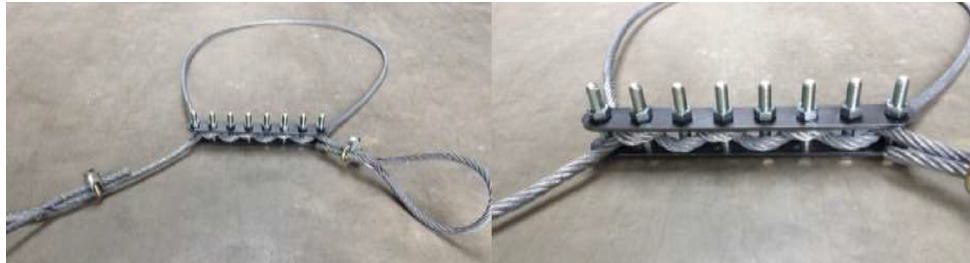
Figure 3. Image of the snake brake provided by the NGE Foundation: it is made of two steel plates connected by a series of bolts through which a cable is braided at both ends of the loop (by courtesy of the NGE